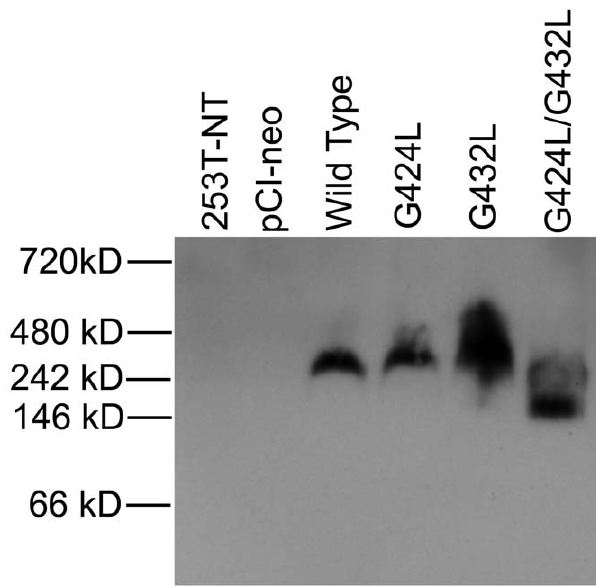
Figure 10. Mobility of G to L Mutants of CEACAM1-4S Resolved by BN-PAGE. Protein lysates were prepared and resolved by BN-PAGE as described under materials and methods. Proteins were transferred onto PVDF membranes and probed with monoclonal antibody 9.2. When separated on native gels, wild type CEACAM1-4S and the single G mutants migrated with an apparent molecular mass that was approximately 100 kDa higher than the double glycine mutant.